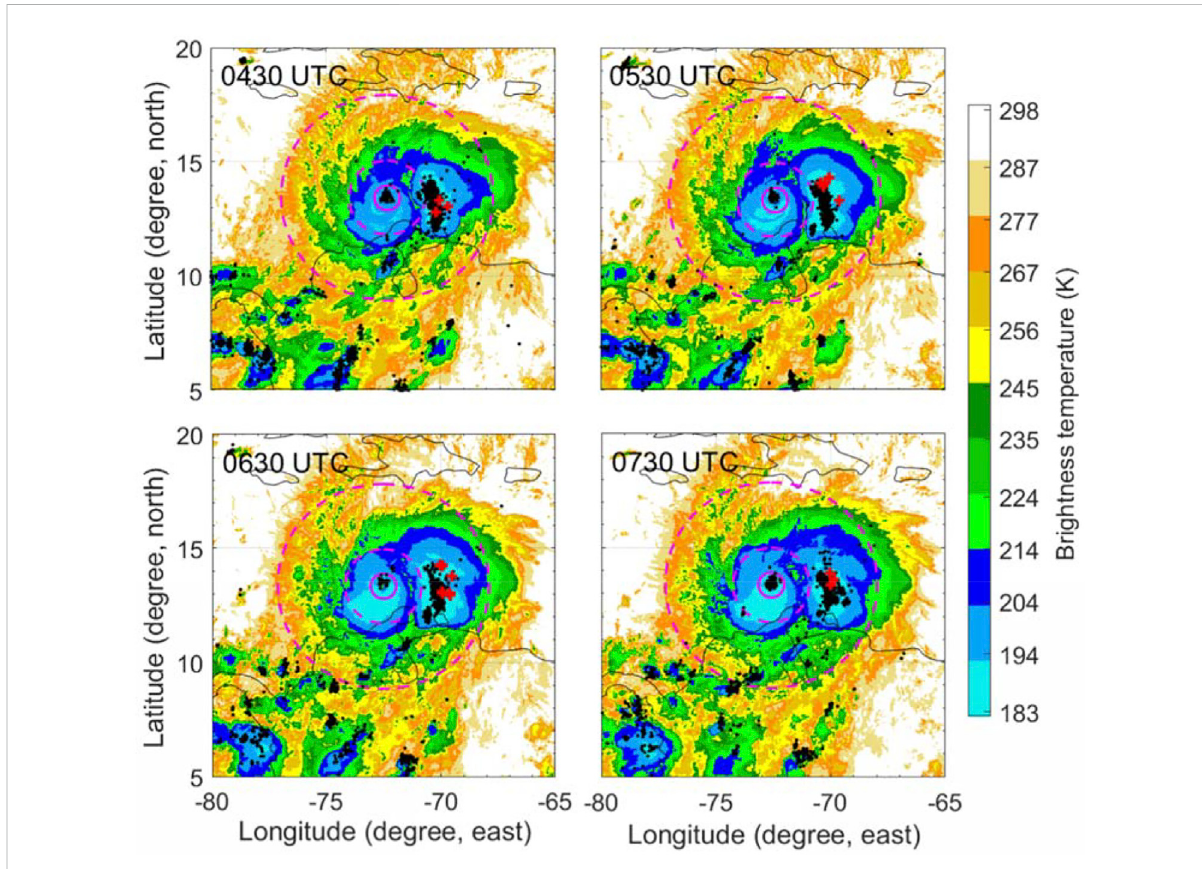
FIGURE 5 Distribution of parent strokes for the sprites observed during four consecutive 1-hour time windows (centered at the time speci fi ed in each panel) over Hurricane Matthew (2016). Adapted from Huang et al. (2018b).